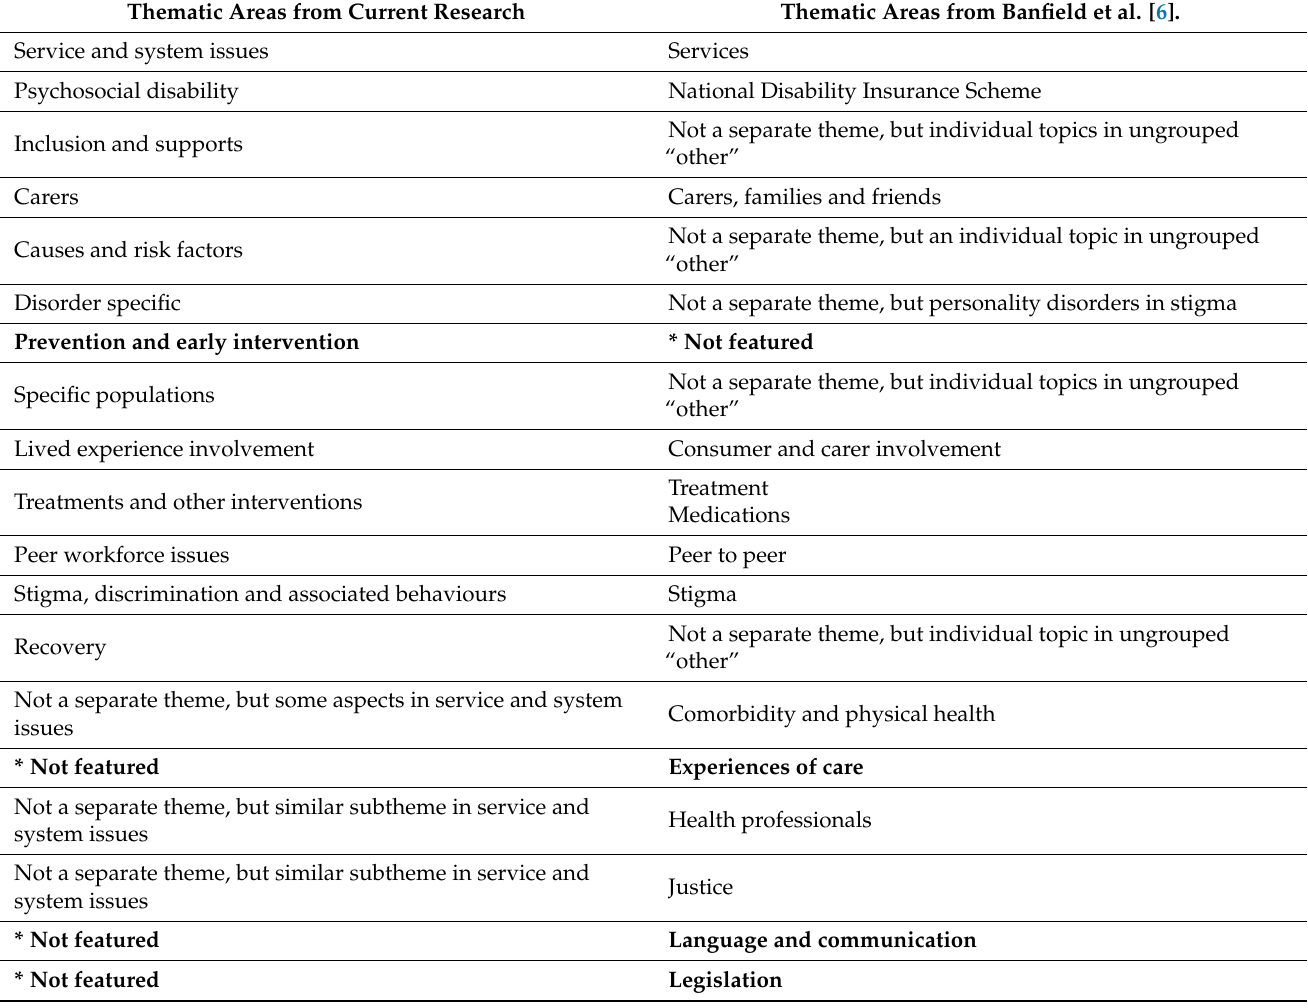
Table 3. Thematic areas from current and previous research in Banfield et al.